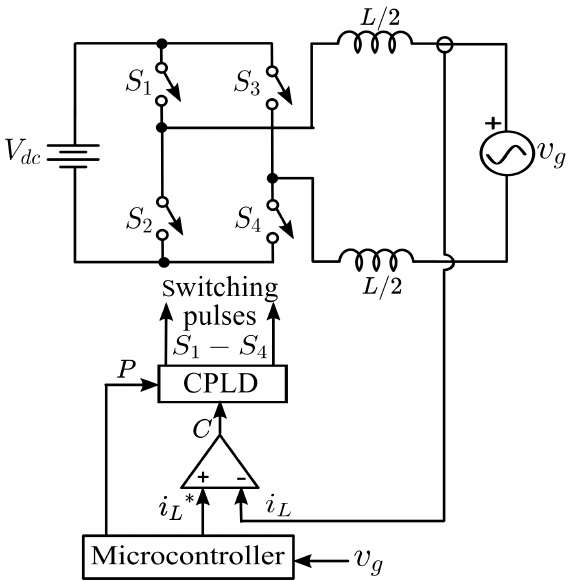
Figure 1. Schematic of the single phase full bridge grid integrated inverter with the proposed logic.